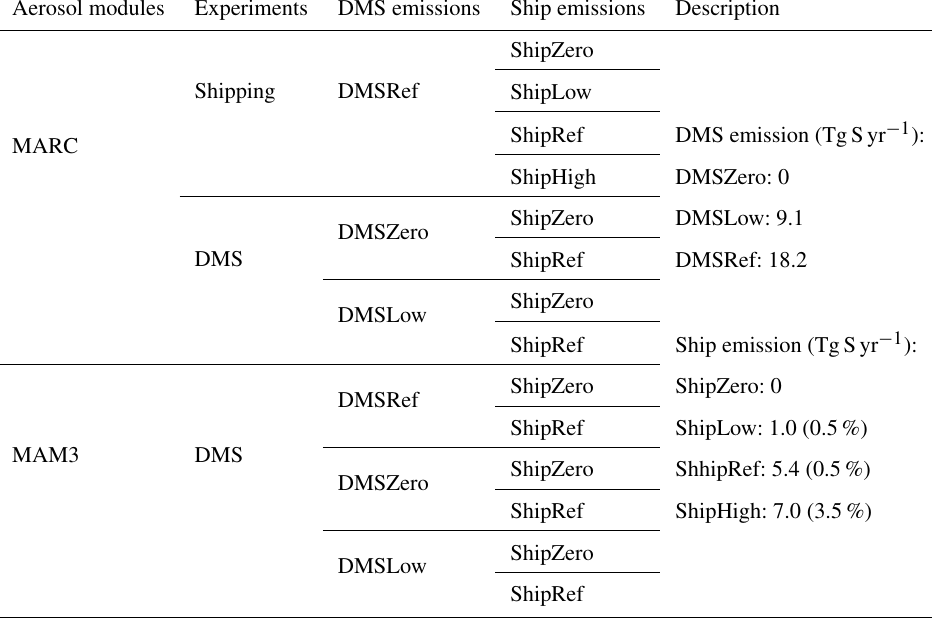
Table 1. Summary of